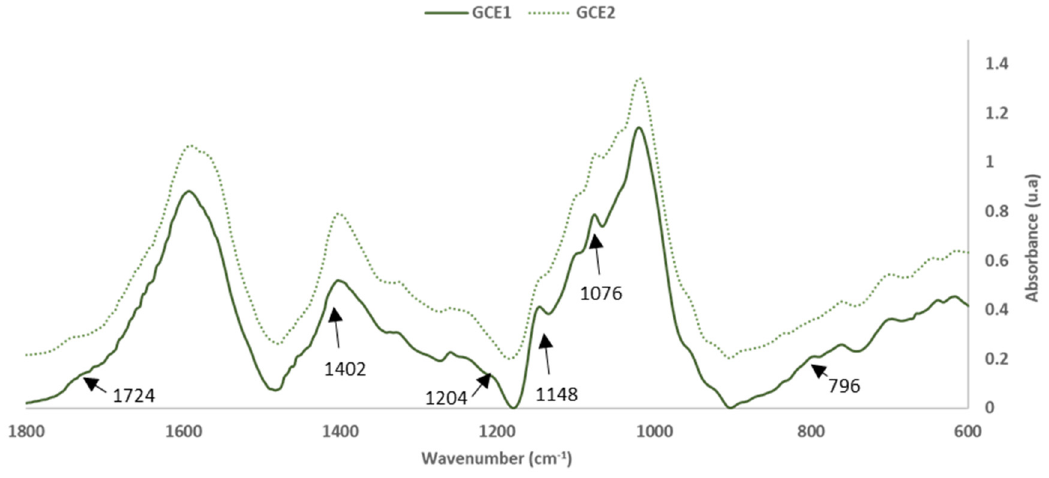
Figure 4. FTIR spectra: Grape cane extracts GC E1 , GC E2 (600–1800 cm − 1 ). The high intensity of the main bands, associated with the presence of condensed tannins at 1454, 1204 and 1020 cm − 1 in the GC E1 spectra versus the GC E2 spectra, confirms